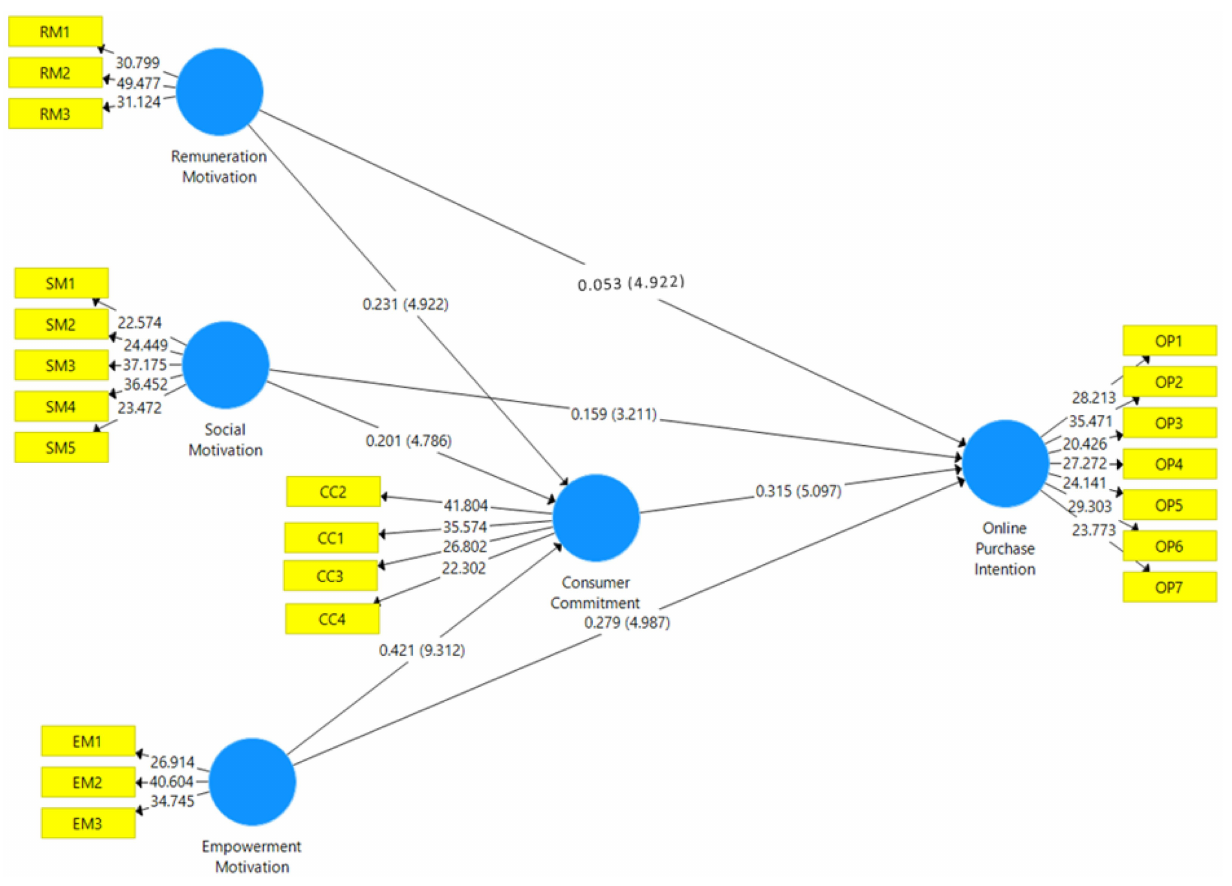
FIGURE 4 | Structural